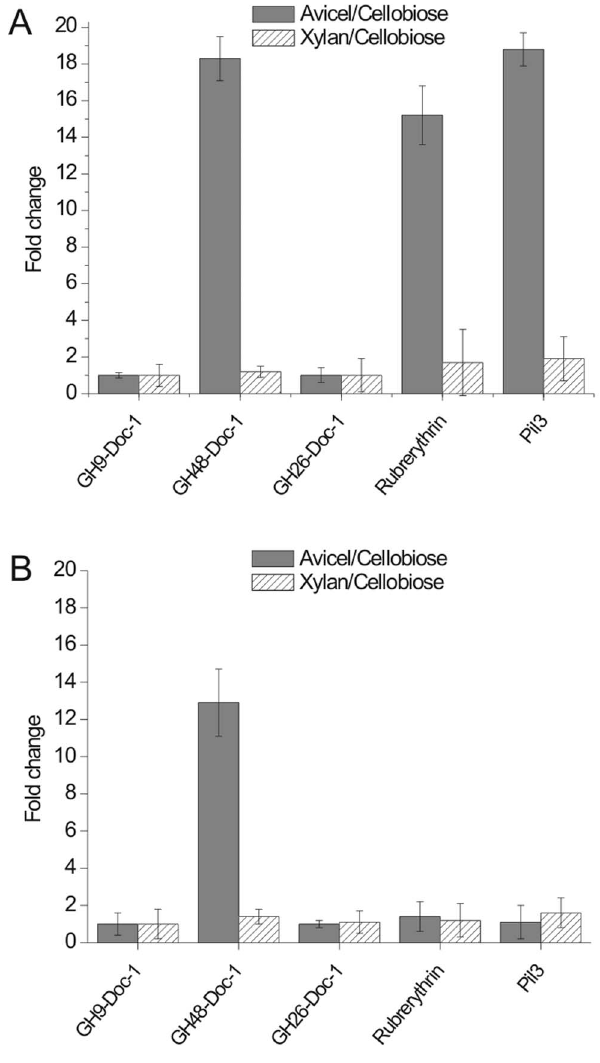
Figure 4. Cellulose-specific changes in expression of culture supernatant proteins in R.flavefaciens strains grown on Avicel (7.5 days), xylan (48 hours) or cellobiose (24 hours). (A) supernatant (CCSUP) fraction of strain 007C, (B) supernatant fraction of strain 007S. 1-fold change indicates no change, . 1-fold change indicates upregulation in comparison to cellobiose-grown cultures, , 1- fold change indicates downregulation in comparison to cellobiose- grown cultures. Results are based on duplicated biological experiments, and three technical replicates for each gel separation.